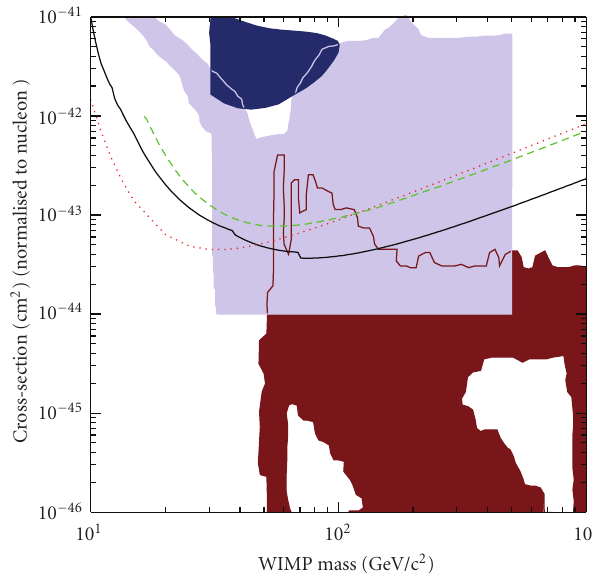
Figure 6: Spin-independent cross section versus WIMP mass with exclusion curves. The blue (top shaded) area is the DAMA claimed discovery region. The remaining shaded areas are regions of parameter space in which theory predicts dark matter candidates. The exclusion curves are: dashed—ZEPLIN III, solid line—CDMS II, dotted line—XENON 10. Models above the exclusion curves are experimentally ruled out. This plot was produced with the Dark Matter Limit Plot Generator